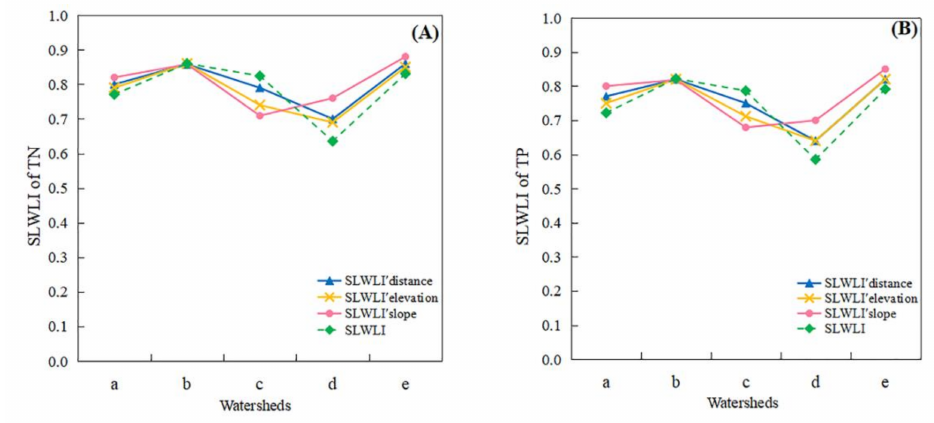
Figure 3. SLWLI of TN ( A ) and TP ( B ) in the five watersheds of the Hani rice terraces.